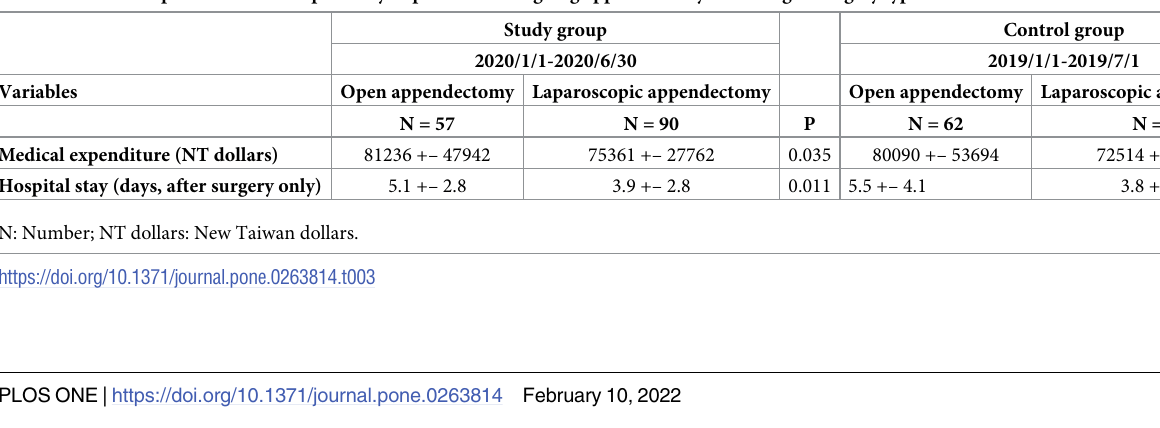
Table 3. Medical expenditure and hospital stay of patients undergoing appendectomy according to surgery